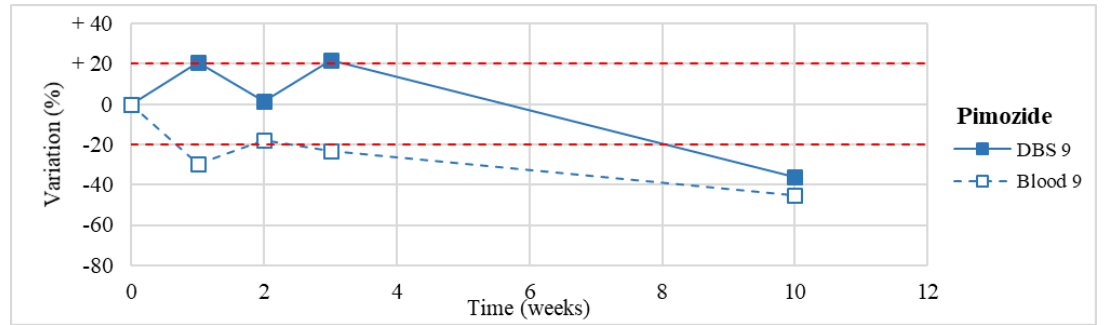
Figure 16. Long-term stability of haloperidol ( n = 1) in DBSs stored at room temperature and in blood stored at −20 °C.